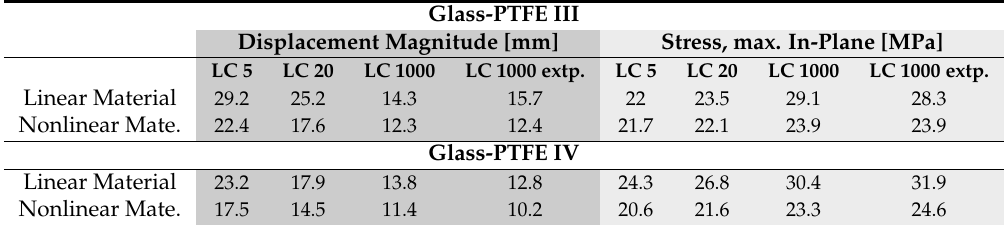
Table 10. The obtained maximum displacement and in-plane Cauchy stress values in simulation of the roof structure. The materials are the glass-PTFE types III and IV with the adjusted and extrapolated